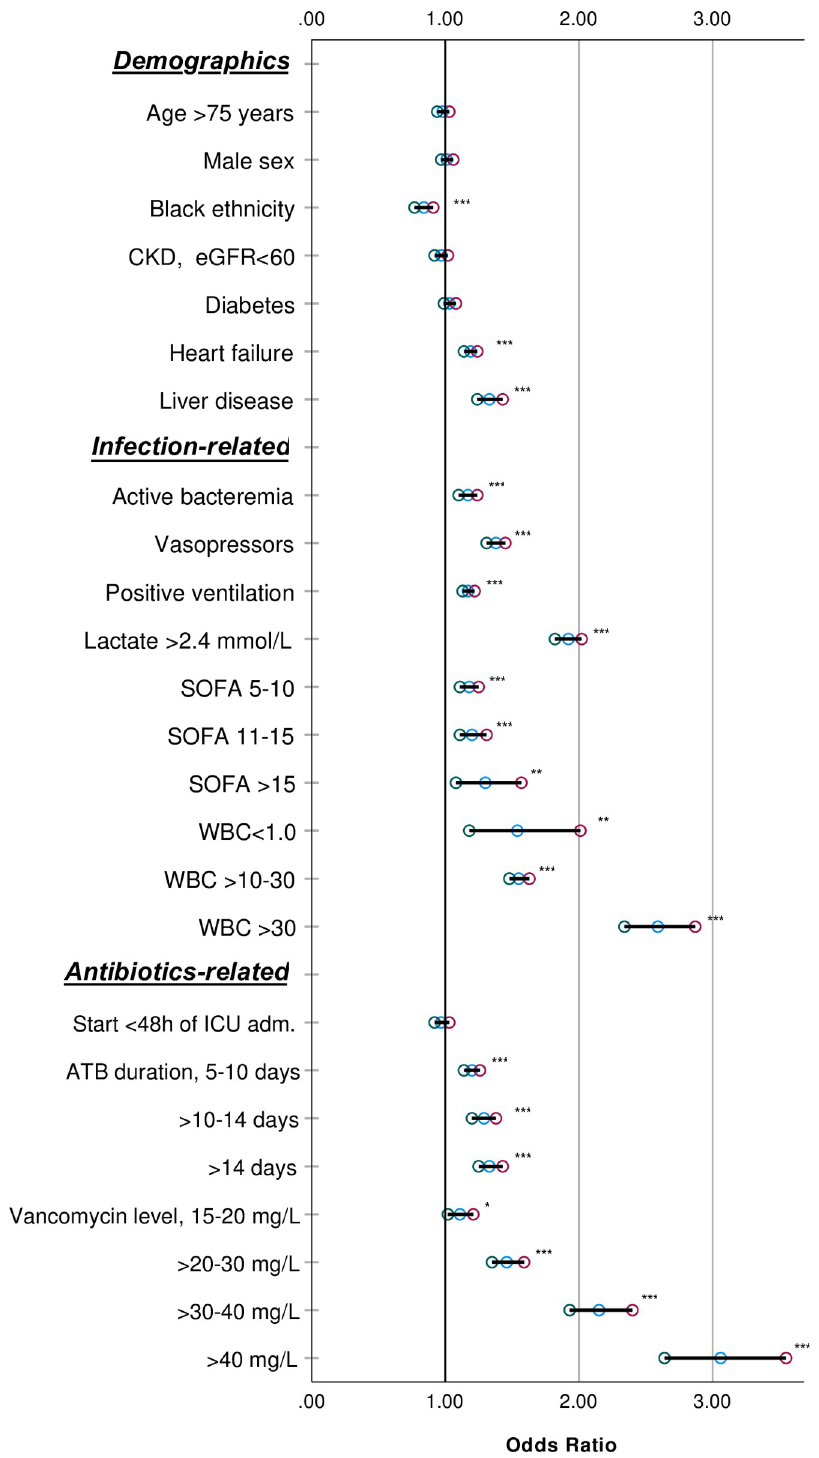
Fig 2. Forest plot of major independent factors associated with new or worsening AKI (primary outcome) within 7 days (univariate). Results reported are Odds ratios with confidence intervals from a generalized estimating equation (binomial GEE) non-ajusted. NS : p-value � .05, � : p-value < .05, �� : p-value < .01, ��� : p-value < .001.